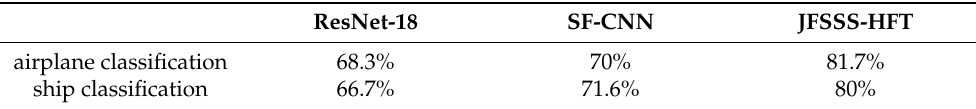
Table 1. Classification results of the proposed features transfer methods compared with deep learning